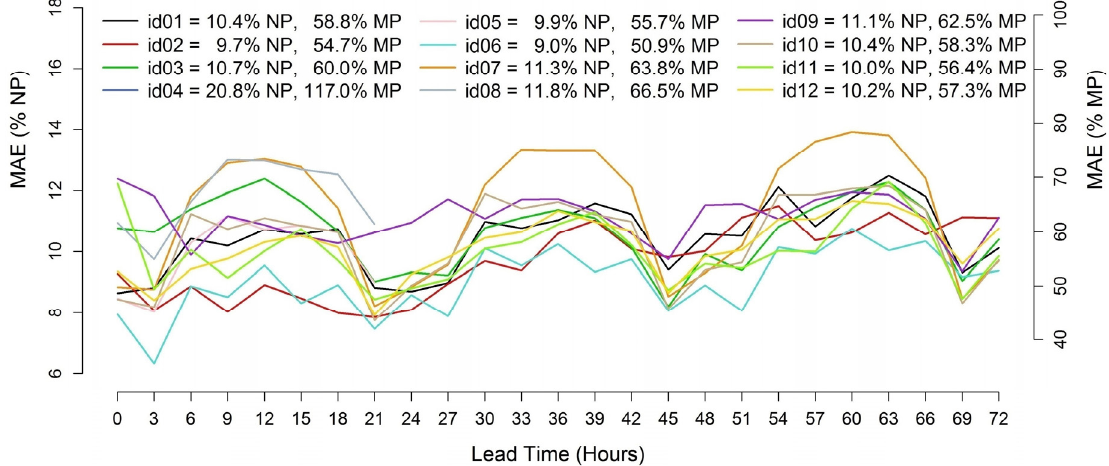
Figure 2. Error trends of the 0–72 h ahead wind power forecasts starting at 12 UTC for the Abruzzo test case ( MAE / NP % and MAE / MP %). MAE : mean absolute error; NP : nominal power; and MP : mean